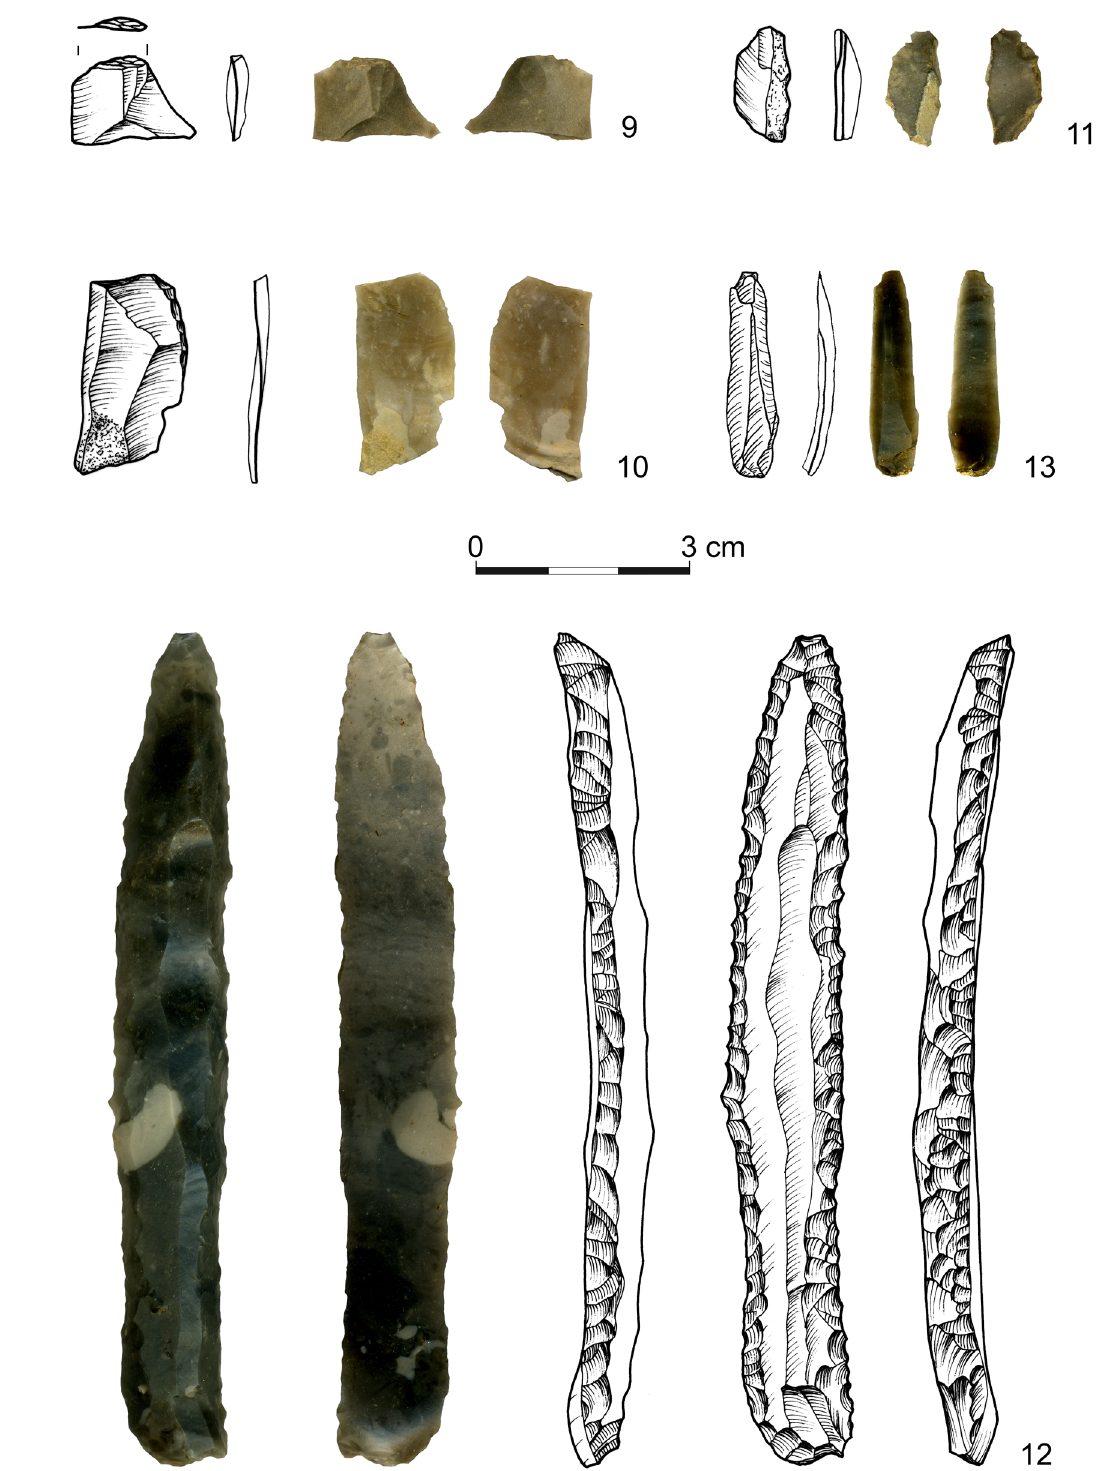
Figure 3. Weklice, Elbląg county. Flint artefacts: 9. flake with negative flake scars on the dorsal surface; 10. mesial fragment of blade with scars on the dorsal surface; 11. partially initial microflake; 12. retouched blade; 13. blade with scars on the entire dorsal surface. (Drawing by E. Gumińska, E. Pazyna and D. H. Werra. Photo by M. Natuniewicz- Sekuła.